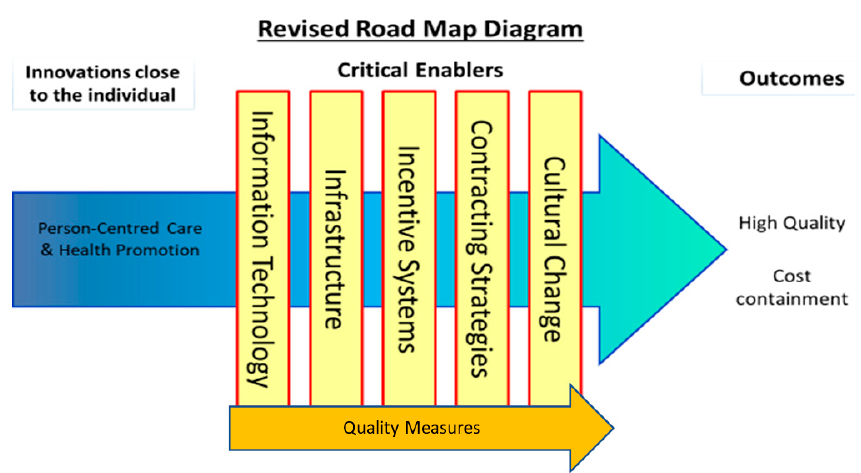
Figure 1. The intersections of critical enablers and the core process of person-centred care and health promotion.